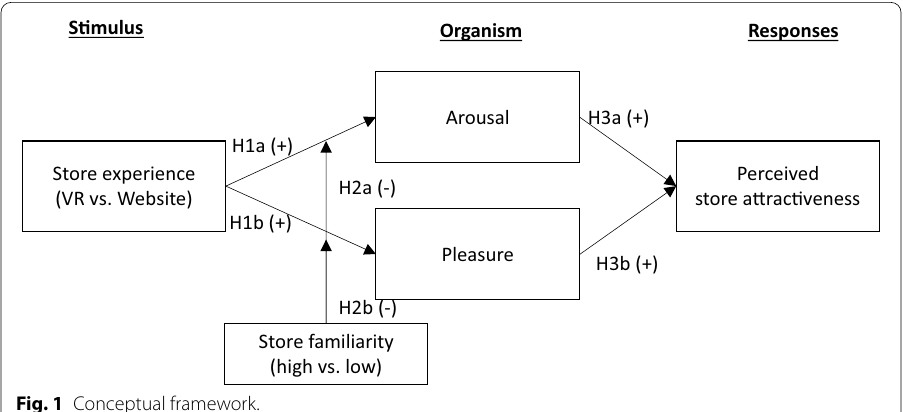
Fig. 1 Conceptual